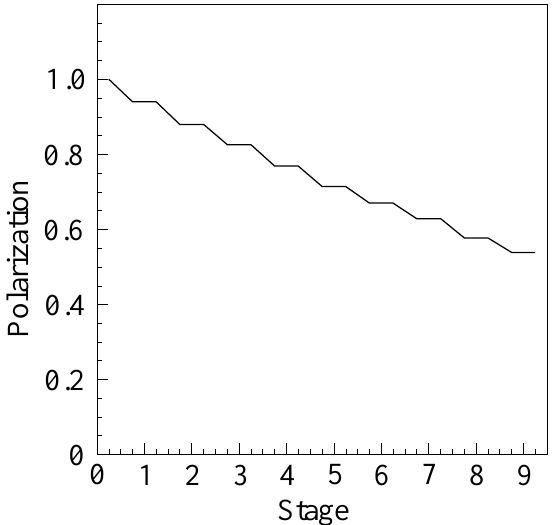
FIG. 7. The polarization of the electron beams.